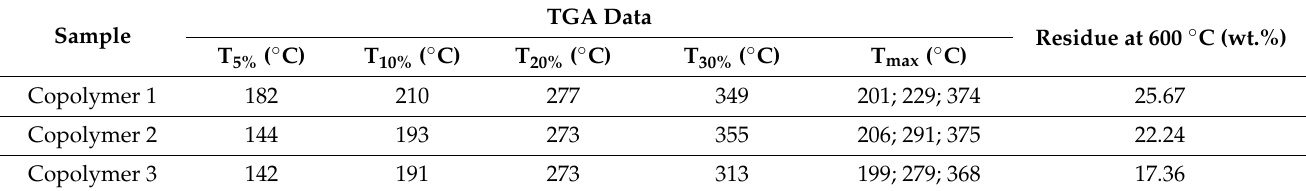
Table 3. Thermal properties of